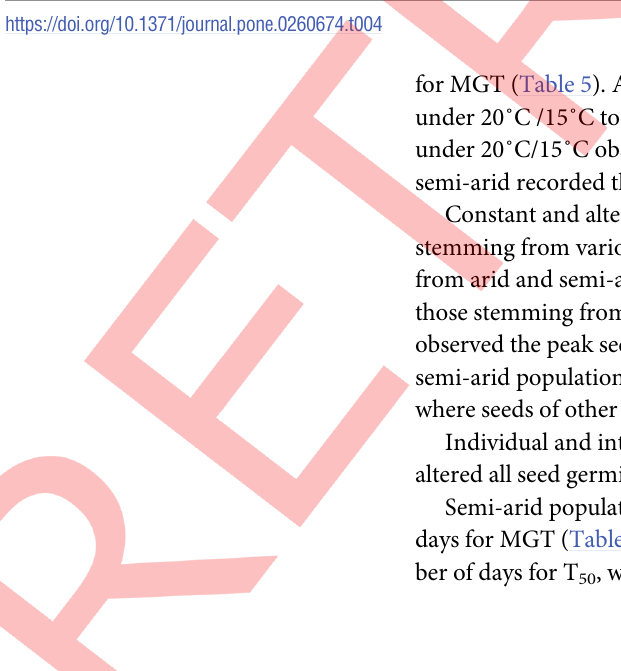
Means followed by same letters within a column or row are statistically similar (p > 0.05) for the respective germination